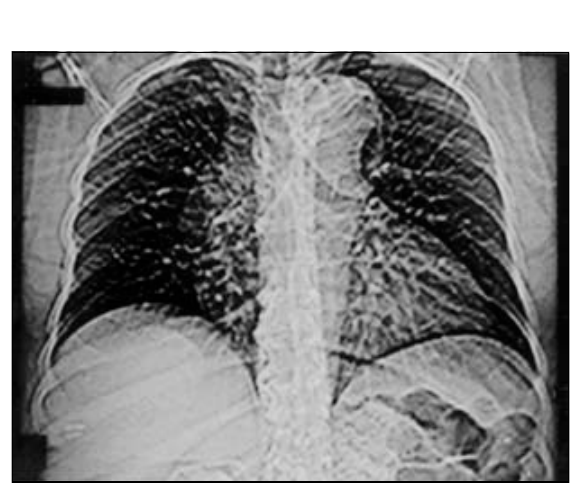
Fig. 1 - Reconstru(cid:231)ªo sagital de imagens obtidas atravØs de tomografia computadorizada durante a avalia(cid:231)ªo